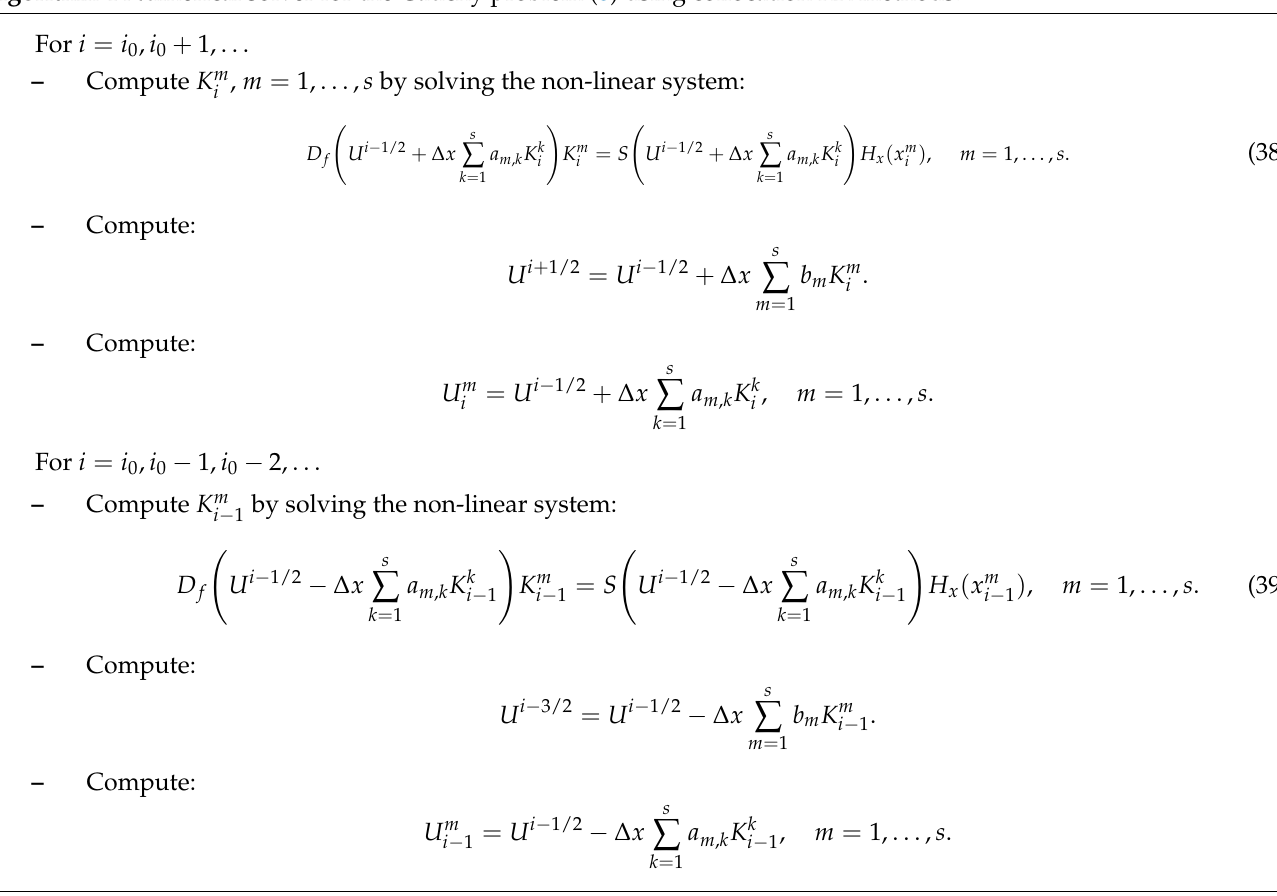
Algorithm 4 Numerical solver for the Cauchy problem (8) using collocation RK